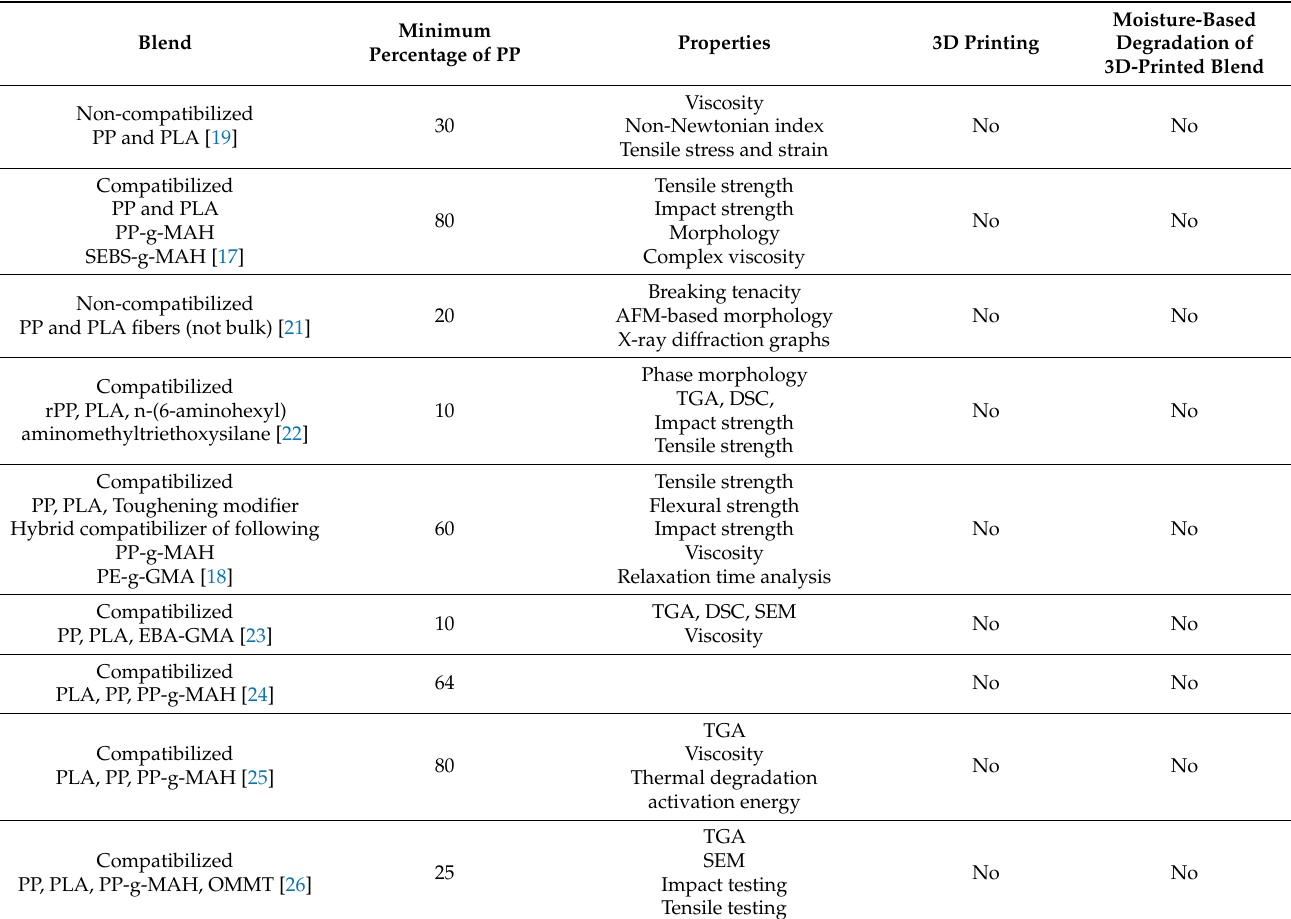
Table 1. Literature review for PP and PLA blend